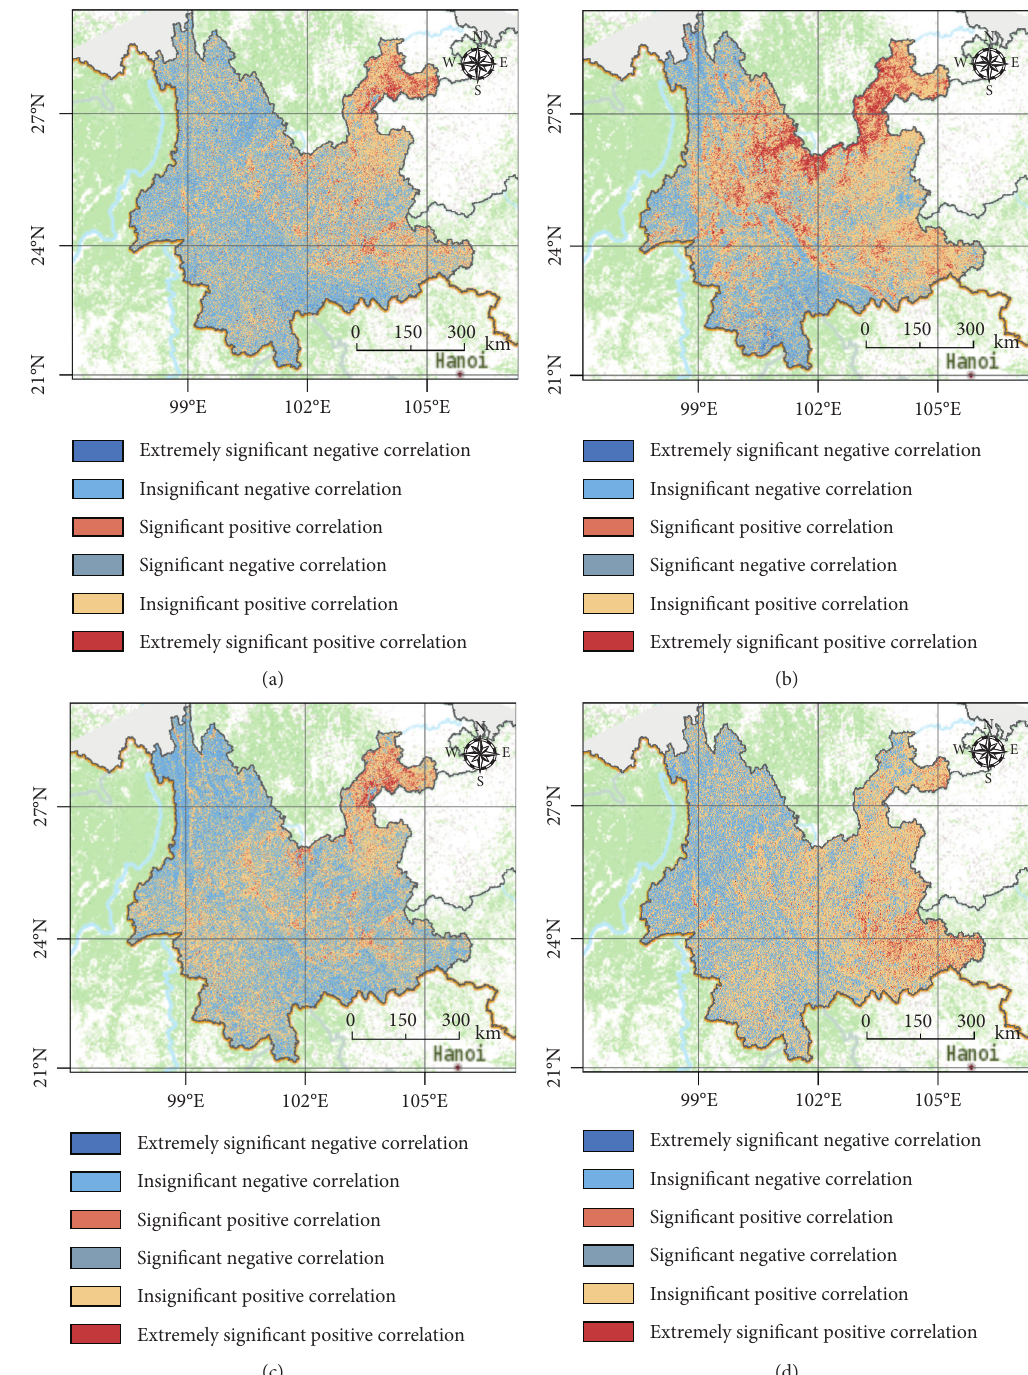
Figure 8: Spatial distributions of correlation coefficients between NDVI and precipitation in different seasons. (a) Growing season; (b) spring; (c) summer; (d) autumn. (a)–(d) represent the proportion of correlation coefficient